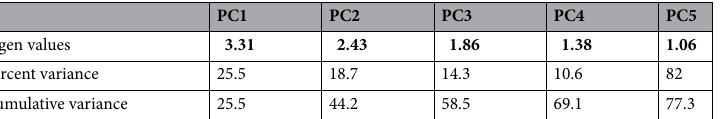
PCA delineated 10 out of 13 traits for effective selection for WDS in maize, viz ., FRW, FSW, DRW, DSW, Chlorophyll, Vigour, TRL, RT, forks, and ARD. For further analysis, these 10 traits have been used. The multi- variate analysis, conducted for 10 seedling traits under osmolyte-induced stress, led the grouping of 71 inbreds in four distinct clusters. Cluster means are given in Table 4. cluster I recorded the highest mean values for DSW, TRL, RT and Forks whereas, the clusters II and III showed intermediate mean values for all traits. Cluster IV recorded the highest means for fresh root weight (FRW), fresh shoot weight (FSW), dry root weight (DRW), dry shoot weight (DSW), vigour (VIG) and chlorophyll content (Chl). The relative performance for seedling traits under WDS was depicted through Heatmap cluster analysis. It showed two types of dendrograms: a genotype